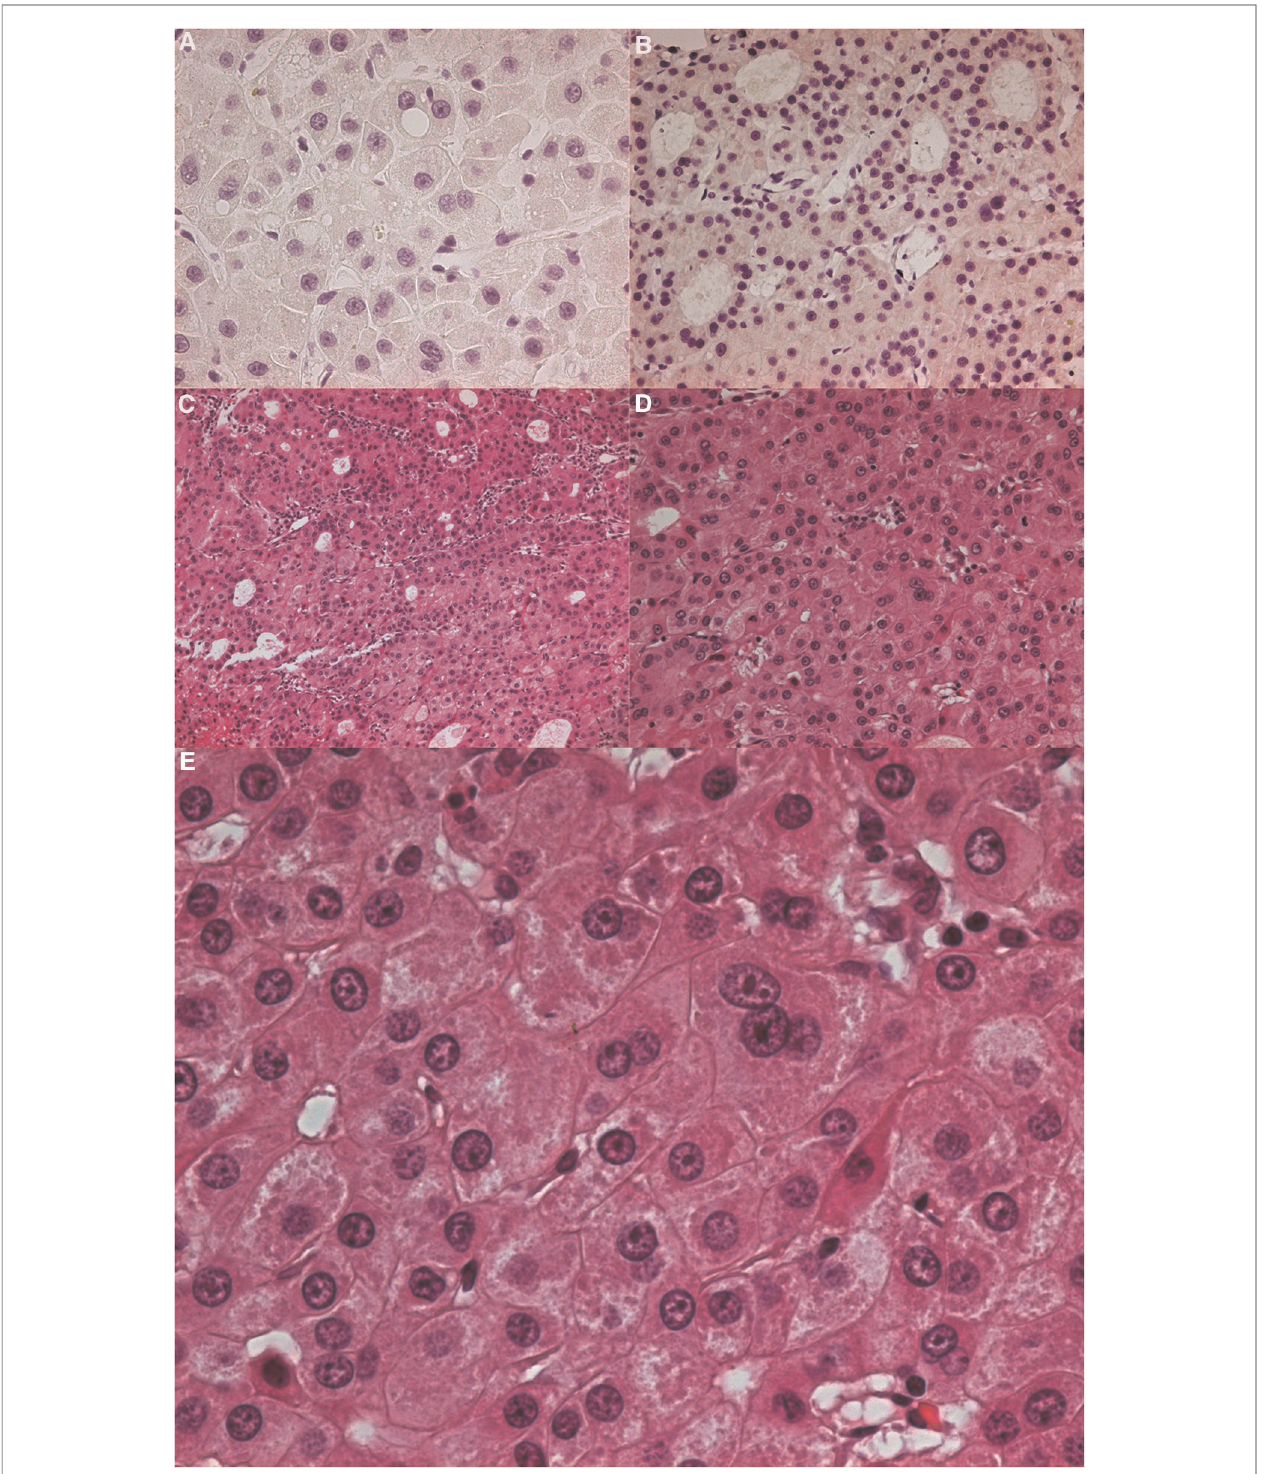
FIGURE 4 | ( A ) immunohistochemistry CK7 ( − ). ( B ) Immunohistochemistry P63 ( − ). ( C ) (HE 100×): Tumour cells were usually arranged in slices, beams or alveolar structures. Occasionally, there was extensive duct differentiation in tumours. The tumour had grown invasively, and perineural and vascular invasion were common. ( D ) (HE 200×), ( E ) (HE 400×): It could be seen that the tumour cells of eosinophilic carcinoma were large, round or polygonal, and the cytoplasm was fi nely granular. It was more pleomorphic than an eosinophilic adenoma. The nucleus was located in the centre of the cell and often had large and irregular nucleoli. HE: Hematoxylin- Eosin